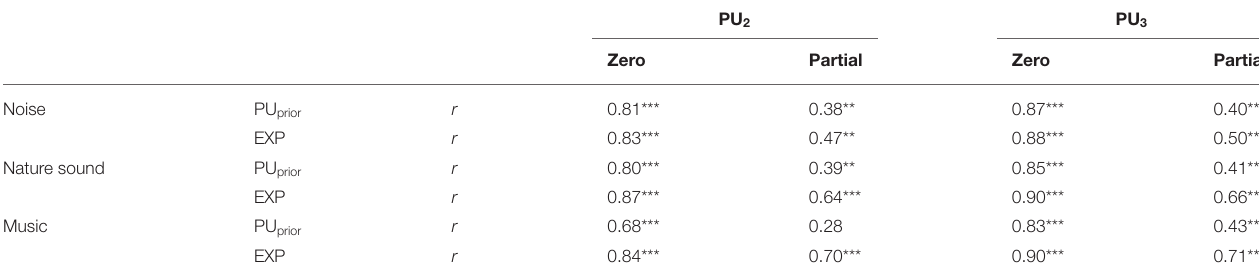
TABLE 2 | Correlations between expected and perceived pain unpleasantness and between prior and perceived pain unpleasantness across auditory excerpts.